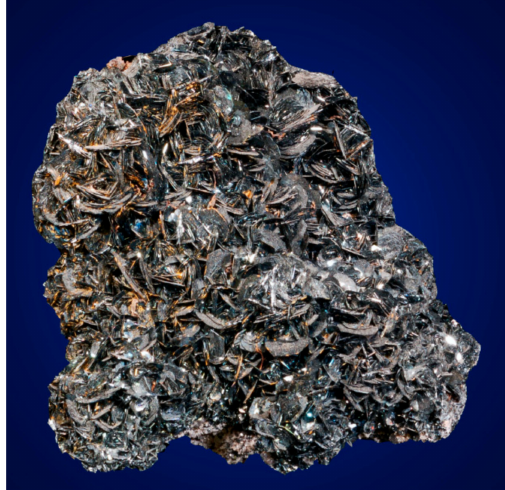
Figure 13. Hematite, Chub Lake prospect. 9.1 cm. Chamberlain Collection, NYSM C5964.